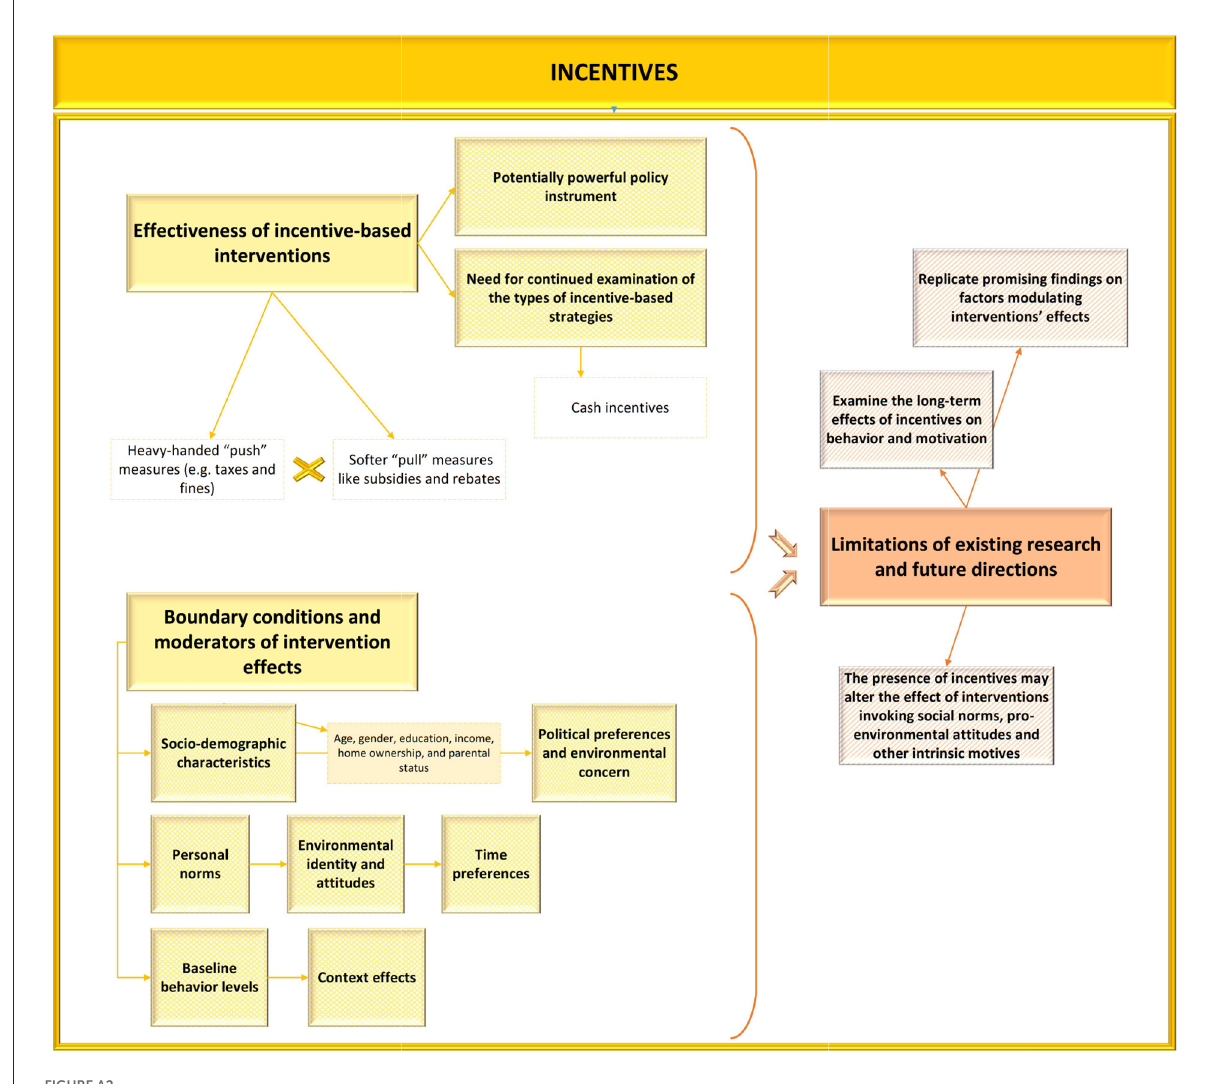
FIGUREA2 Overview of findings on